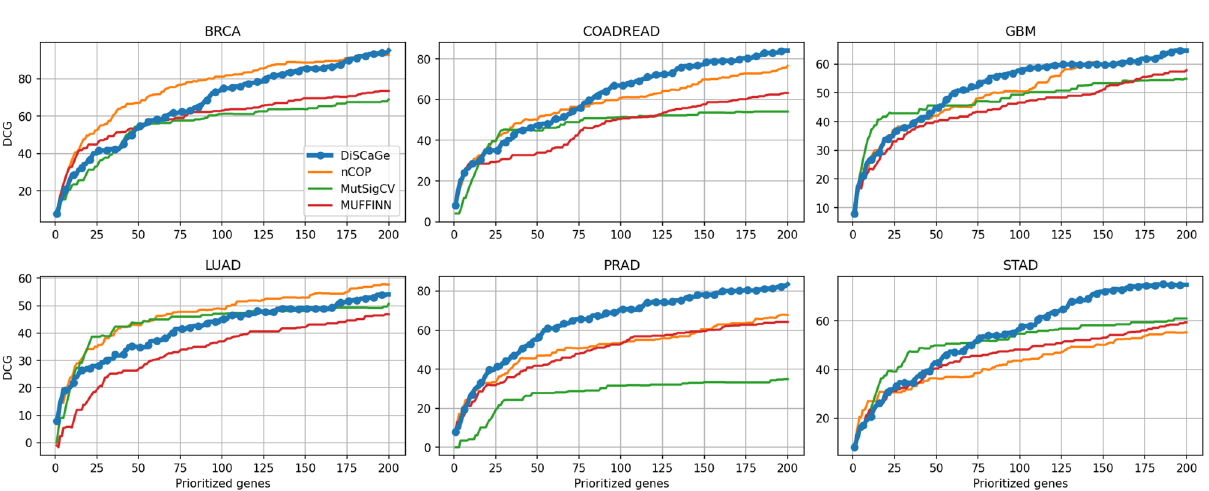
Figure 3. Precision of DiSCaGe and related methods: shows the fraction of prioritized genes (y-axis) contained in the known driver benchmarks for a specific number of genes (x-axis).